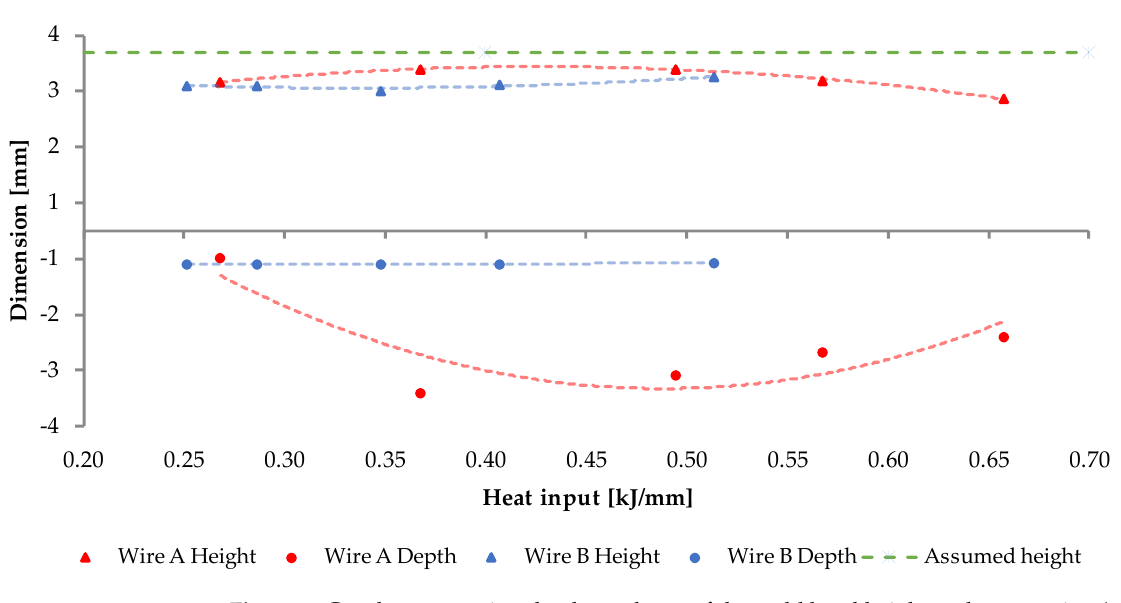
Figure 9. Graph representing the dependence of the weld bead height and penetration (marked as “depth”) on the heat input level. The red and blue dashed lines express the second order interpolation, while the green dashed line marks the assumed, target value for the reference.